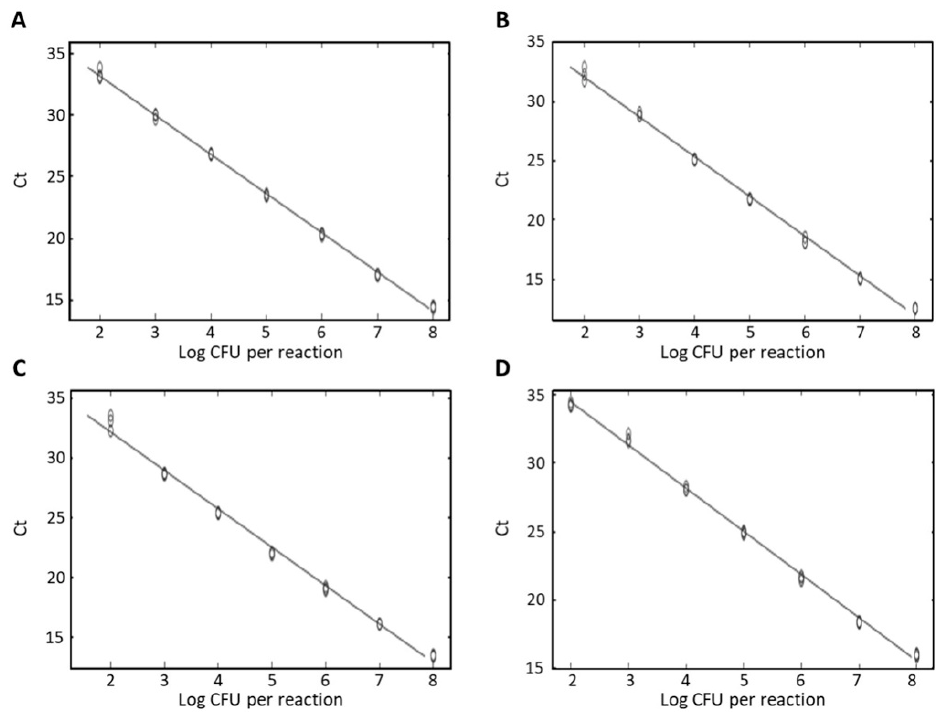
Figure 4. Limit of detection for ( A ) S. aureus , ( B ) S. capitis , ( C ) S. caprae , and ( D ) S. epidermidis in spiked milk samples. Table 3. Identification of strains isolated from food